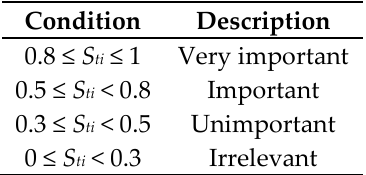
Table 3. Relevance of an input parameter from its global sensitivity